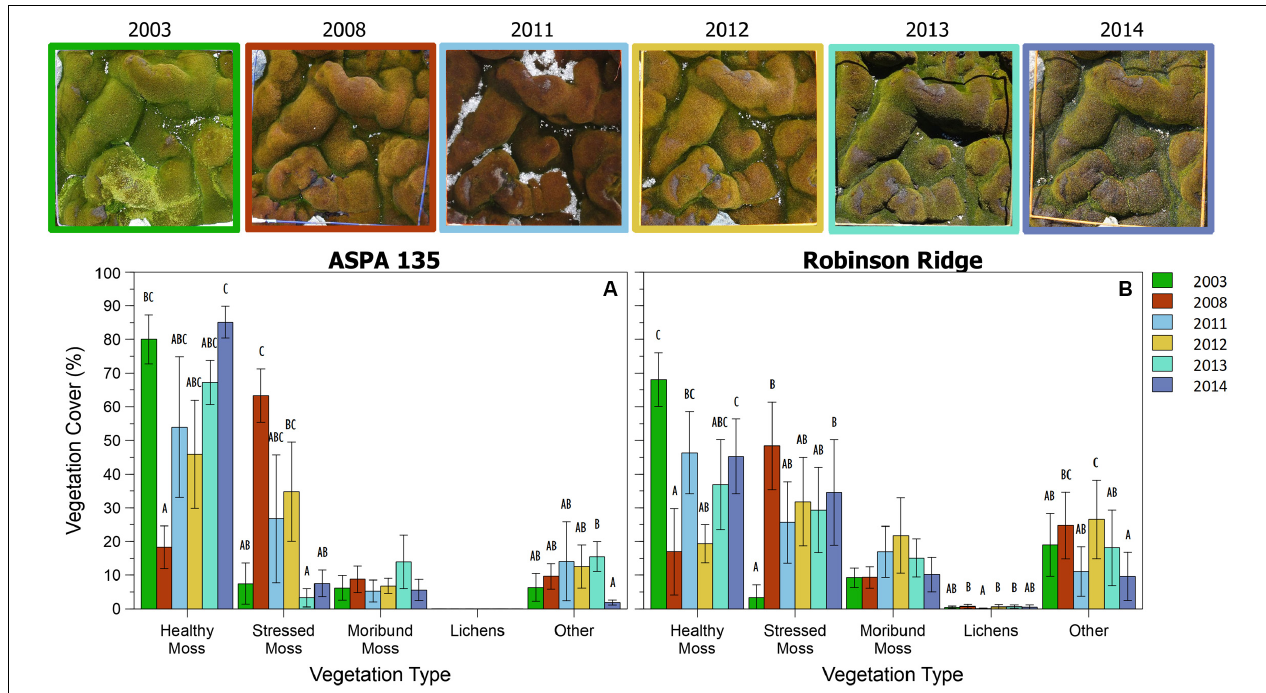
FIGURE 6 | Trends in Bryophyte community vegetation cover from 2003 to 2014 at two sites in the Windmill Islands, A2 (A) and RR (B) . Photographs depict a representative quadrat (site A2, quadrat B3) at each of the six time points. Data are mean percent cover of vegetation ± 95% CI. Different letters denote significant differences between years per vegetation